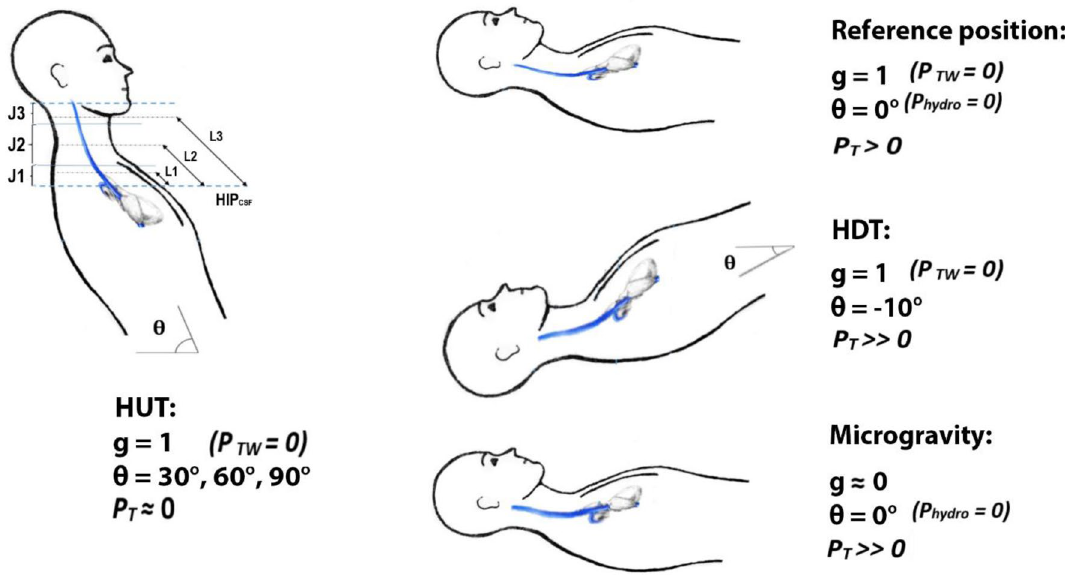
Figure 2. Left: Illustration of the three modelled IJV segments (J1–J3) and the corresponding vessel lengths (L1–L3) measured from the hydrostatic indifference point (HIP CSF ) of a subject in head-up tilt position (HUT). Right: supine (reference position, top), head-down tilt (HDT, middle) and microgravity (bottom) condition. θ tilt angle, g normalized modulus of gravity acceleration vector with respect to g Earth , P T IJV transmural pressure, P hydro hydraulic pressure, P TW tissue weight